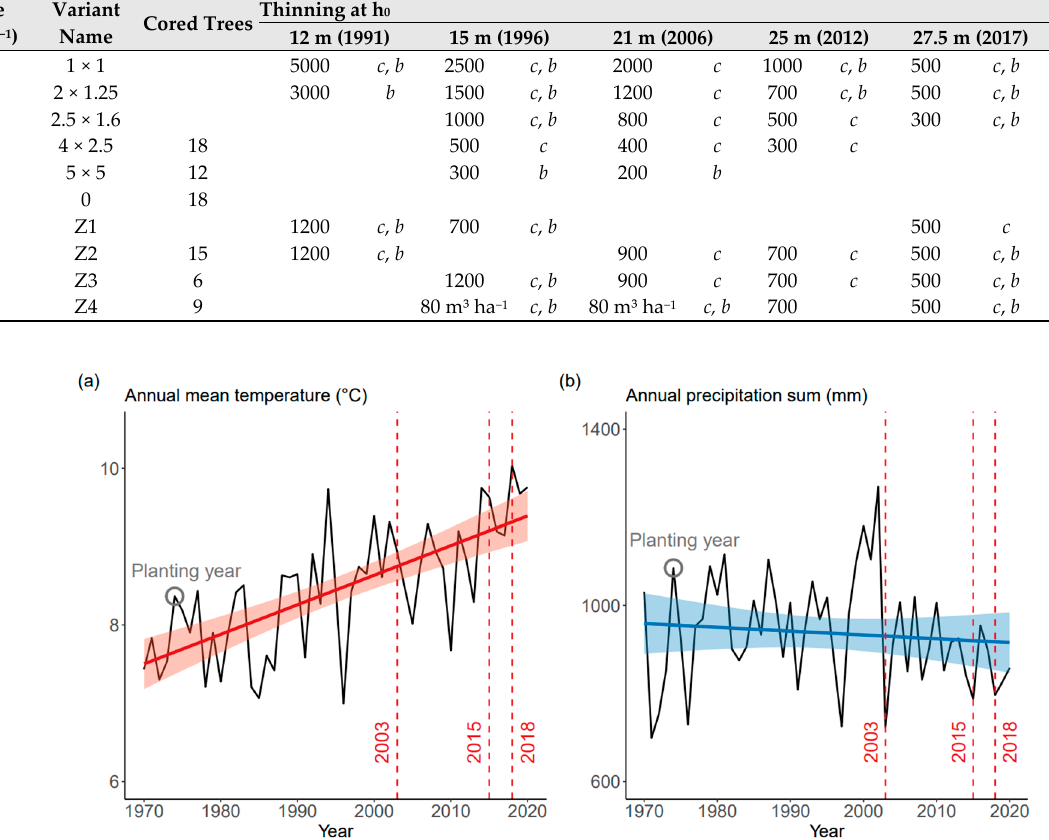
Table 1. Detailed information on the realized spacing and thinning variants. A = spacing trial; B = thinning trial (IUFRO). Plot number and variant name columns refer to the study design presented in Figure 2. Bold plot numbers indicate plots where tree cores were taken from the buffer zone. The second column reflects the initial tree number per hectare when planted in 1974. In the other columns, the staggered thinnings are listed. For each thinning, the remaining number of trees, respectively the remaining volume, is displayed per hectare. The letters c and b listed behind represent the thinning methods used: c = crop tree thinning, b = thinning from below, or c , b = combination of both.